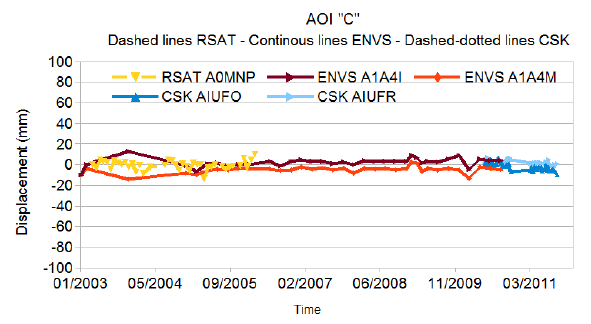
Figure 9: Displacement recorded in the AOI "C" using Cosmo-SkyMed. Radarsat and Envisat satellites